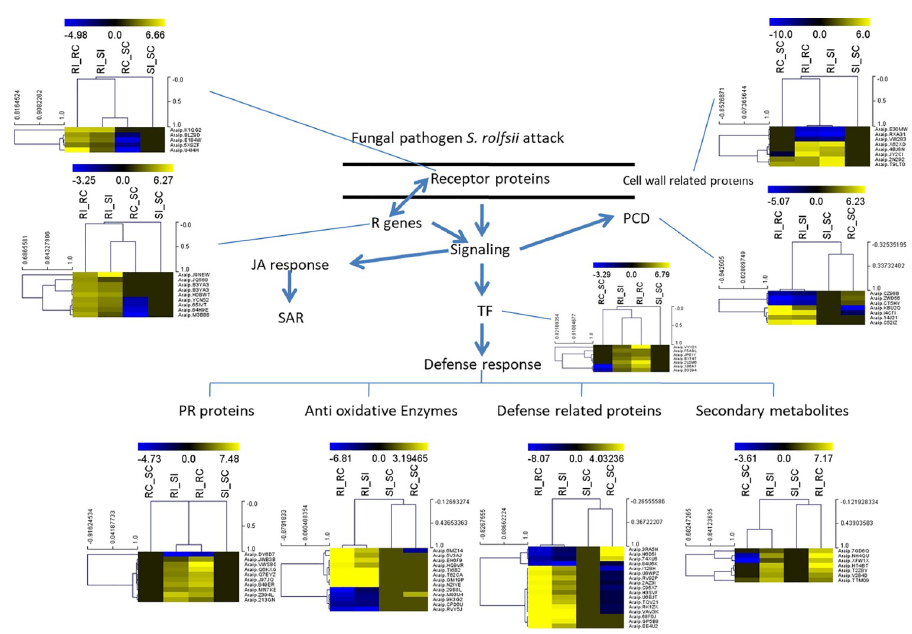
Fig 4. A putative defense response against the infection with Sclerotium rolfsii in peanut through various types of transcripts. The relative expression levels of each transcript are presented as a heat map (hierarchical clustering with Pearson’s uncentered correlation and complete linkage method). Scale represents down-regulation/low expression and up-regulation/high expression.